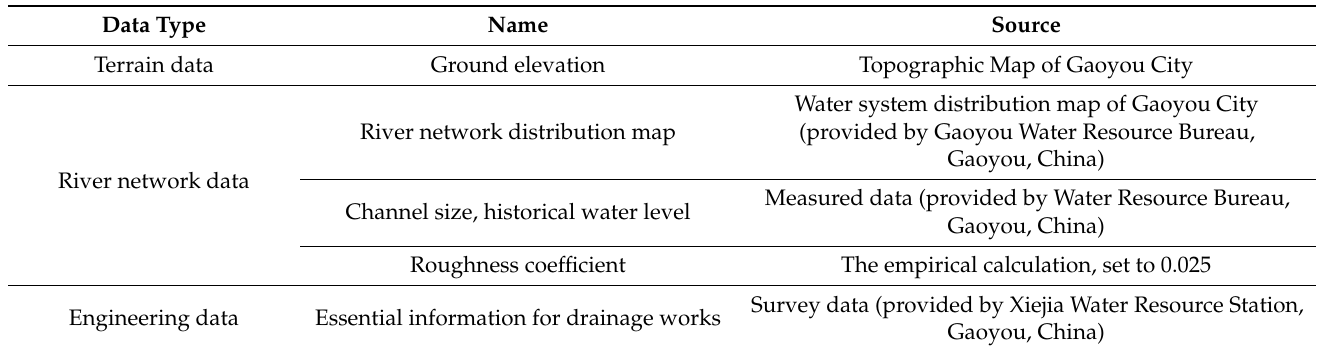
Table 4. Main data for the model and its